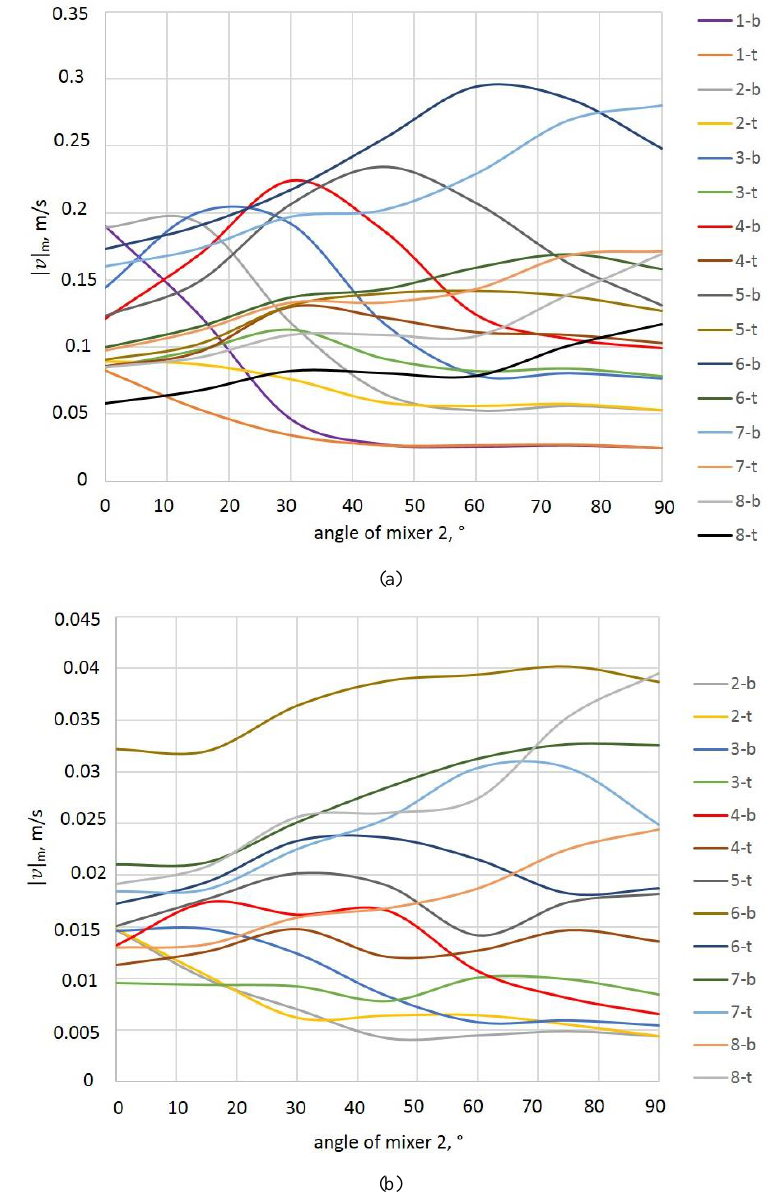
Fig. 9. Velocity profiles of the bottom and top zones depicted in Fig. 8 as function of the angle of mixer 2: (a) averaged value of flow velocity; (b) Z-component of the flow